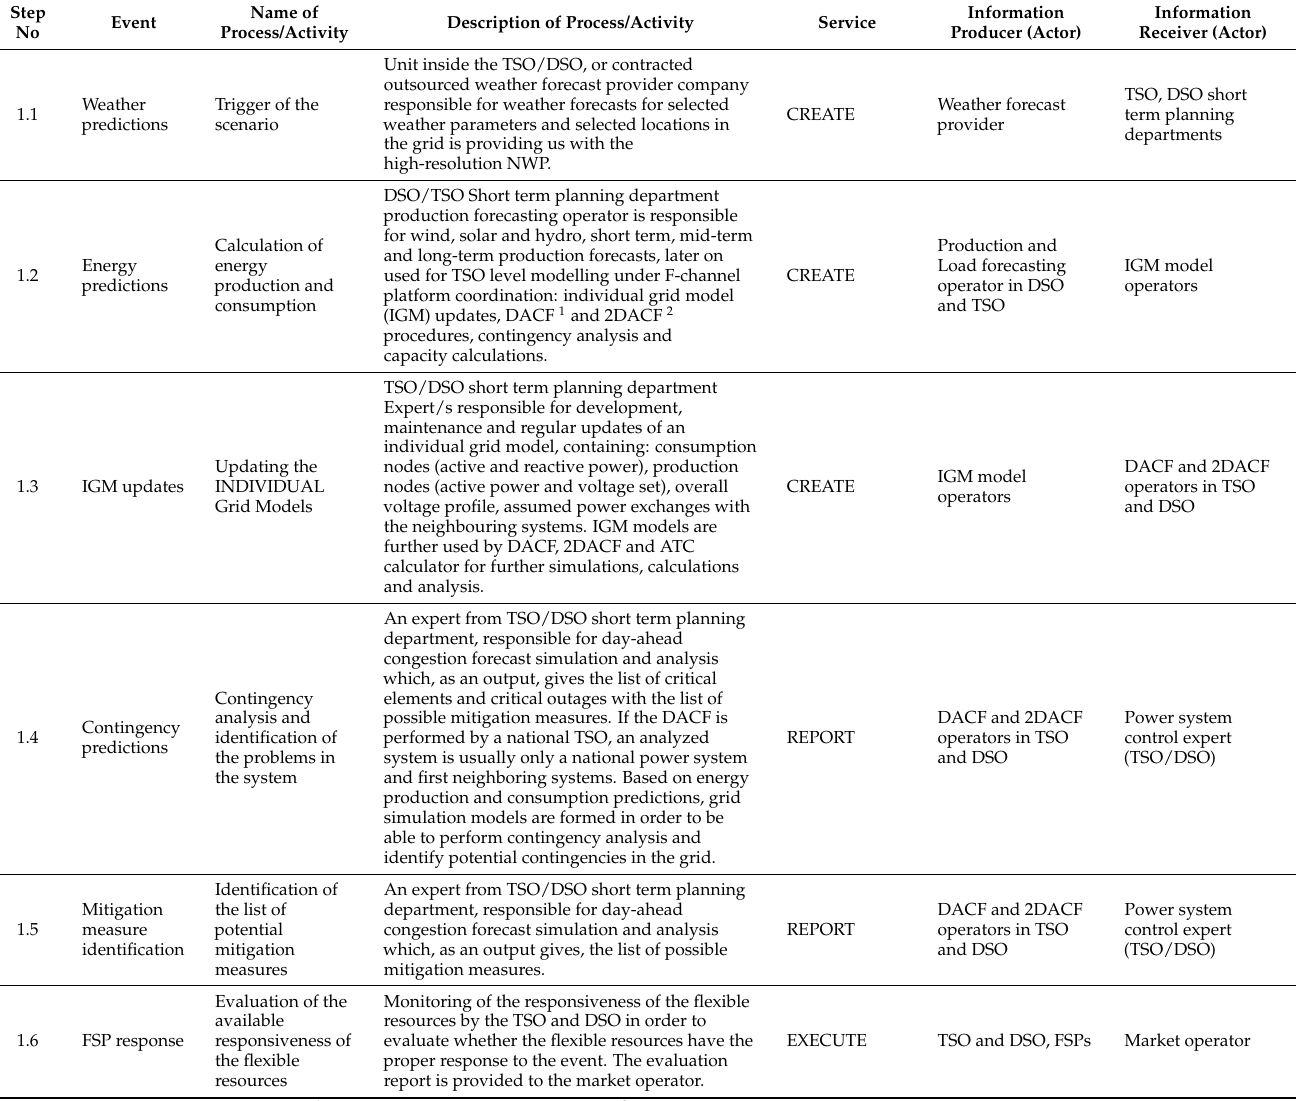
Table 4. Step-by-step analysis of Scenario